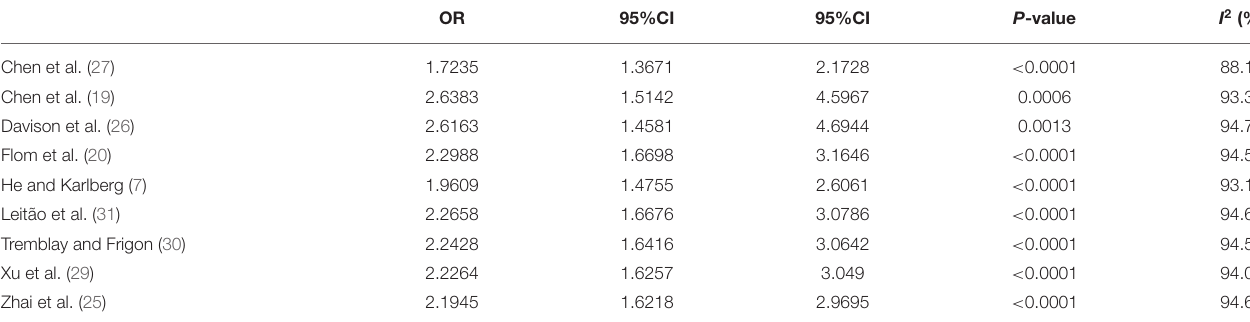
TABLE 3 | Sensitivity analysis for the association of childhood overweight/obesity and early puberty in girls.